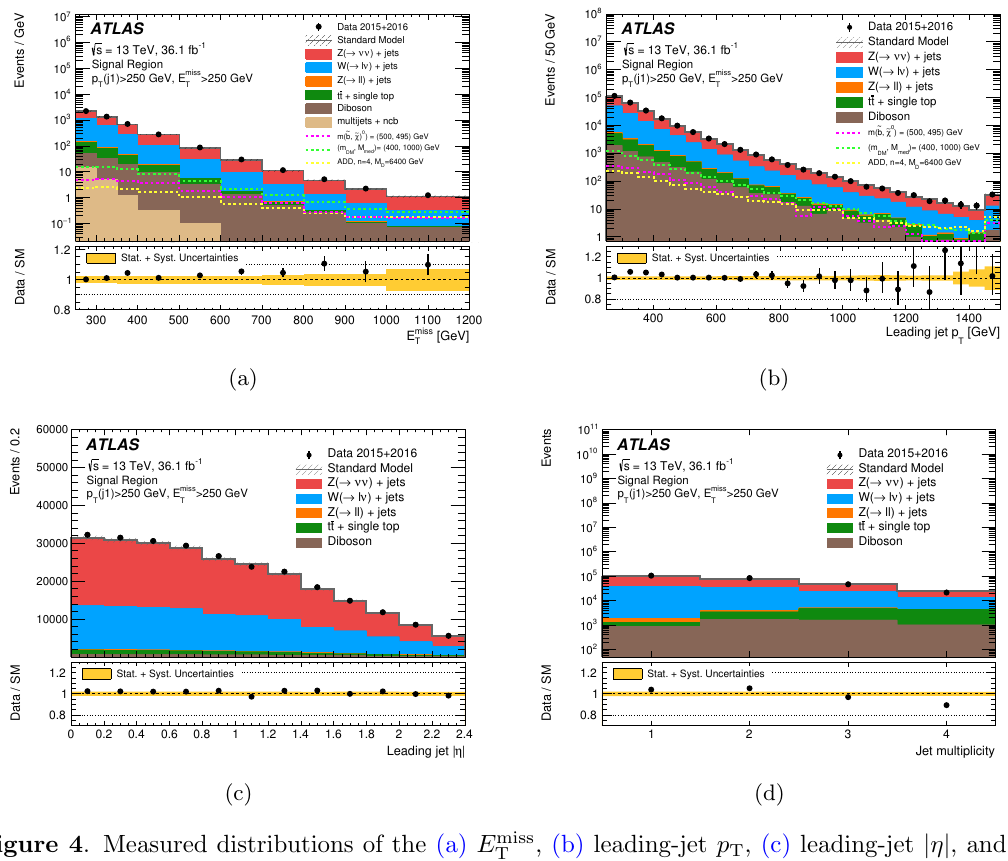
, (b) leading-jet p T , (c) leading-jet j (cid:17) j , and (d) Figure 4 . Measured distributions of the (a) E miss T jet multiplicity for the E miss T